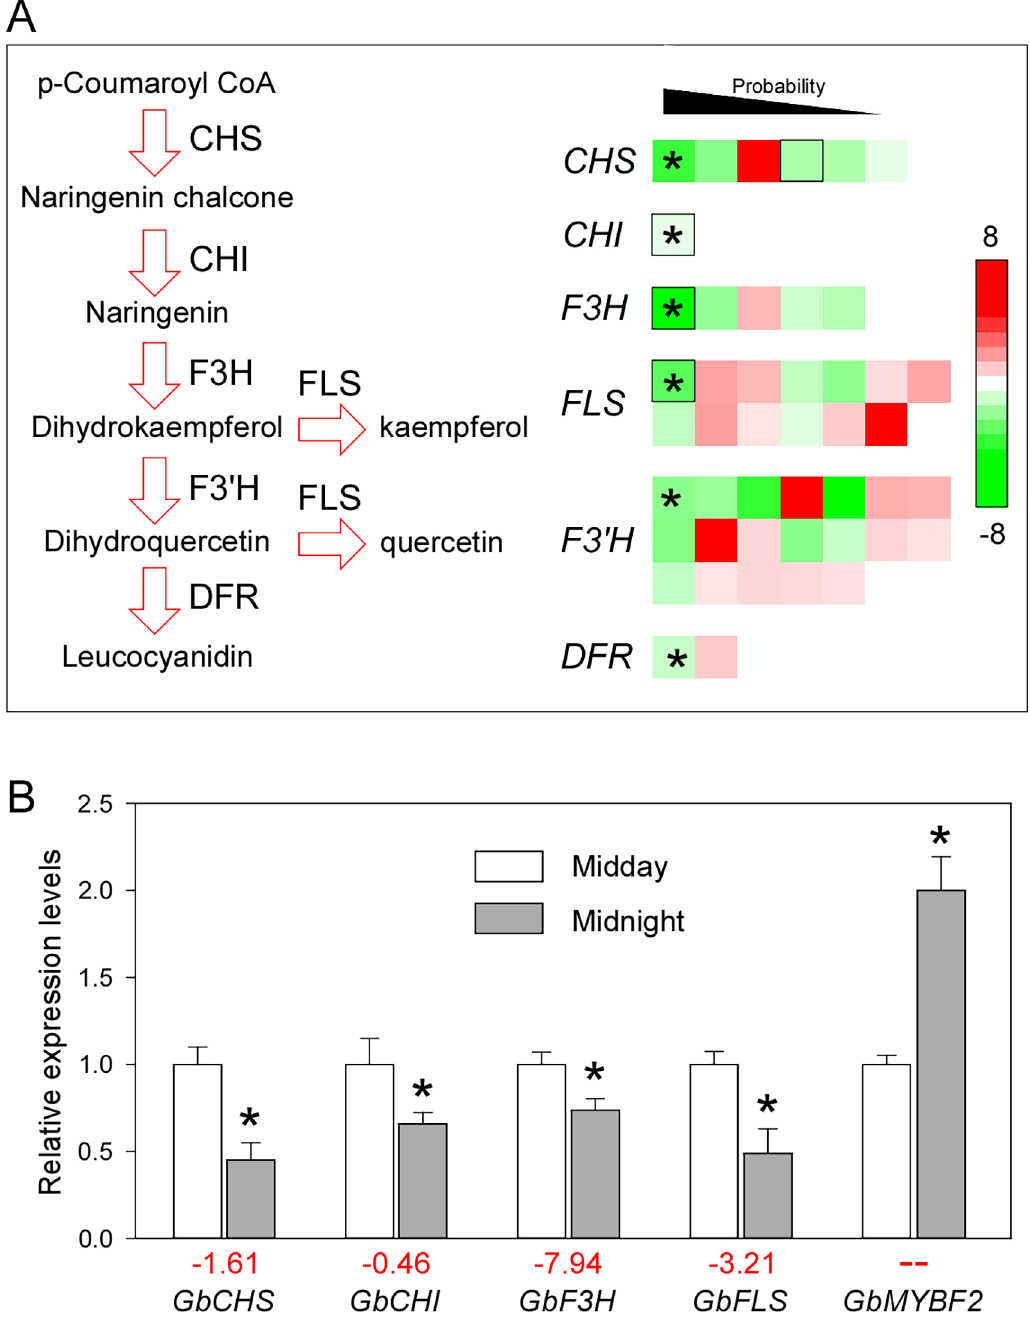
Fig 3. The expression levels of flavonoid biosynthesis-related genes. (A) Diagram of flavonoid biosynthesis and the expression changes of corresponding genes according to the sequencing analysis. The different colors correspond to the log2-fold change of gene expression levels. Asterisks indicate the gene expressions with the highest probabilities. Unigenes validated by RT-qPCR are marked with black boxes. (B) Relative expression levels of flavonoid biosynthesis-related genes. Asterisks indicate significant differences ( P < 0.01; Student’s t -test). Red numbers under the bar graphs are log2-fold change values of each gene acquired in the transcriptome analysis. Three independent replicates were performed for midday and midnight (mean ± SD).